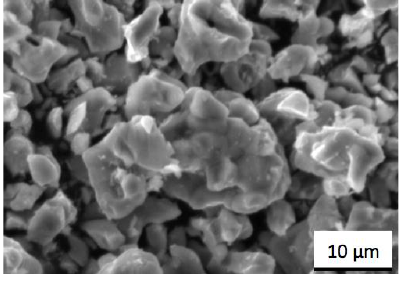
Figure 7. SEM image of CrB 2 initial powder.